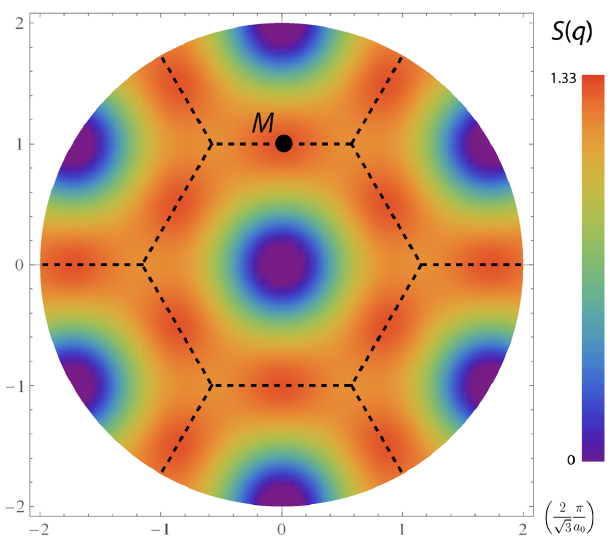
FIG. 5. Spin structure factor for pinned singlets. Equal time spin correlations h S þ S − i for spins frozen into randomly oriented short-ranged valence bonds show a deep minimum at the Brillouin zone center; a 4 ∶ 1 ratio of first-to-second-neighbor bonds also give a broad maximum at the edge midpoint M . Both features are seen in neutron scattering [5 –